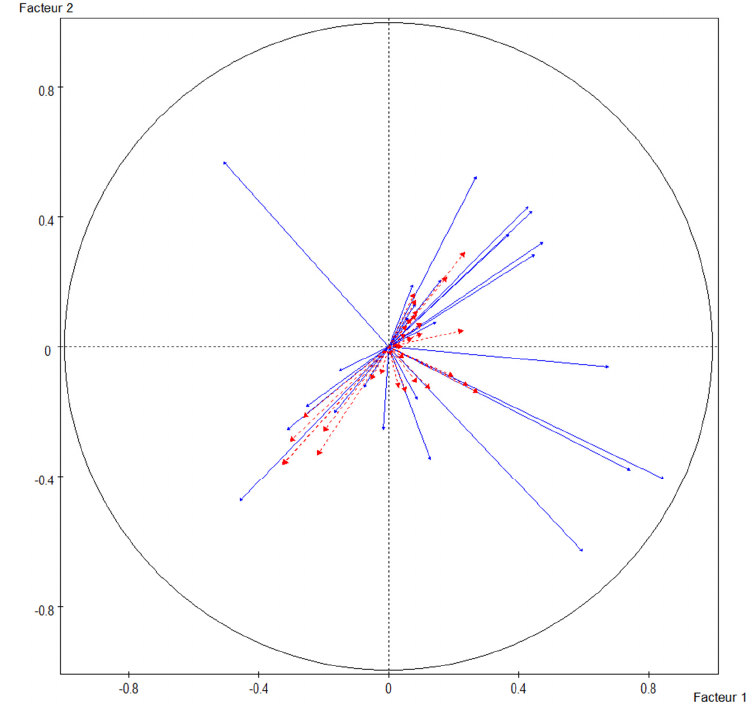
Figure 6. Biplot of PCA in the Islands district.